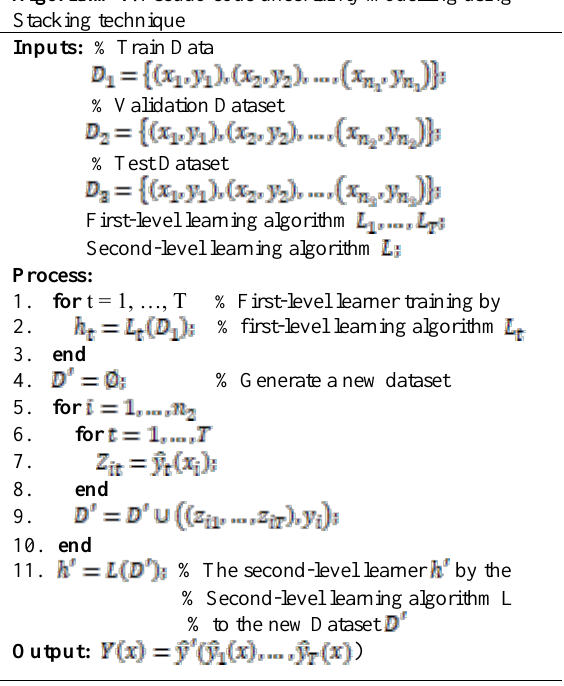
Figure 1 . The general structure of the proposed uncertainty modelling using Stacking technique Algorithm 1 . Pseudo code uncertainty modelling